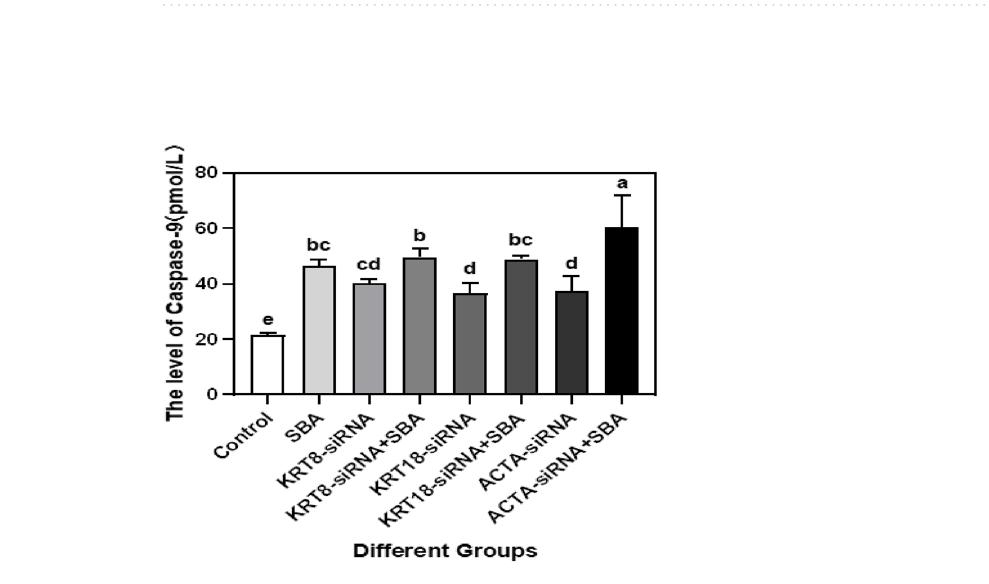
Figure 11. Caspase-9 activation in different treatments. IPEC-J2 were treated in different treatments (Control treatment (T1); SBA treatment (T9); KRT8-siRNA treatment (T2); KRT8-siRNA + SBA treatment (T10); KRT18-siRNA treatment (T3); KRT18-siRNA + SBA treatment (T11); ACTA-siRNA treatment (T4); and ACTA-siRNA + SBA treatment (T12)) for 24 h. Caspase-9 activities were determined using the double antibody sandwich method of ELISA. Each column represents the mean ± SEM of three independent experiments. Different lowercase letters indicate the significance of differences between different treatment groups ( p <